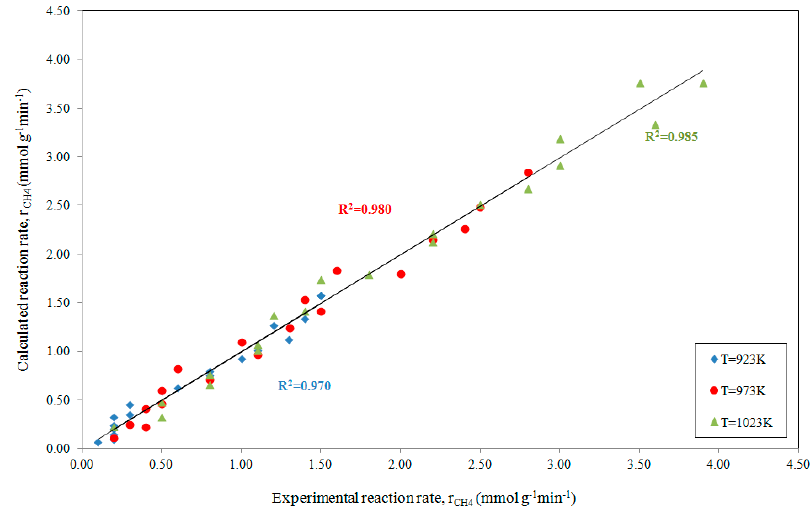
Figure 2. Parity plot for the rate of CH 4 consumption, at increasing reaction temperatures, when comparing experimental data [19] with estimates obtained using ANEMONA after fitting Model 4 for the methane dry reforming reaction.